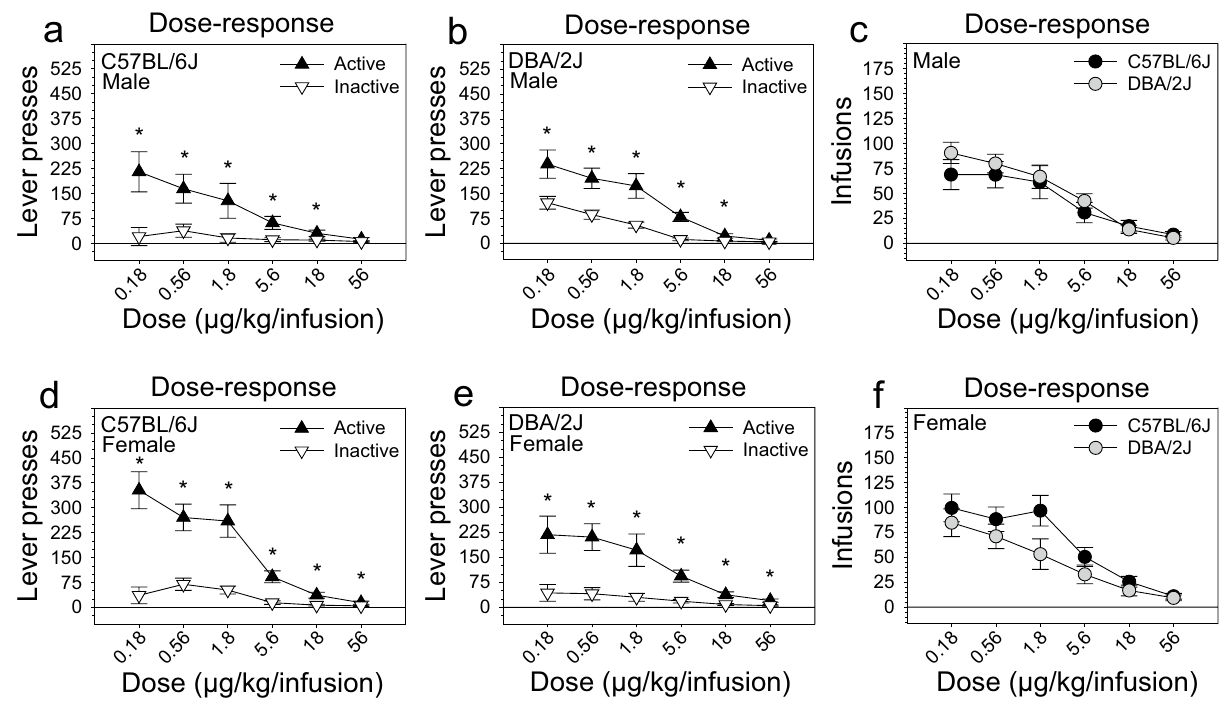
Figure 2. Dose–response of intravenous fentanyl self-administration in C57BL/6J and DBA/2J mice. ( a , b , d , e ) Male and female mice from both strains pressed the active lever significantly more than the inactive lever on almost all doses, and active lever pressing increased as fentanyl dose decreased (lowest dose vs highest dose: p < .001). ( c , f ) Number of infusions did not differ as a function of strain or sex. Data are presented as the mean ± S.E.M. * p <